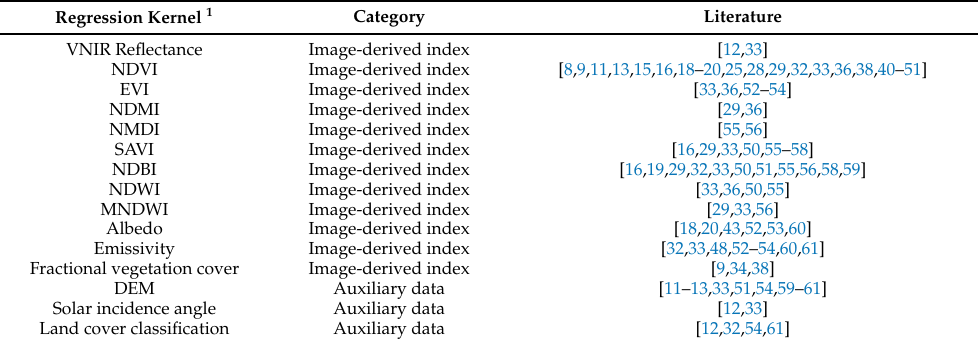
Table 2. Overview of the regression kernels used in LST spatial resolution enhancement